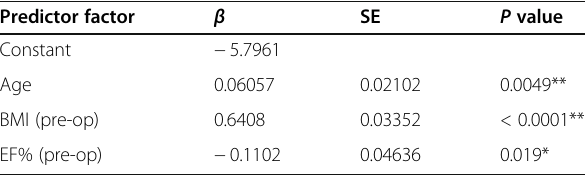
Table 6 Multiple regression model for the factors affecting postoperative